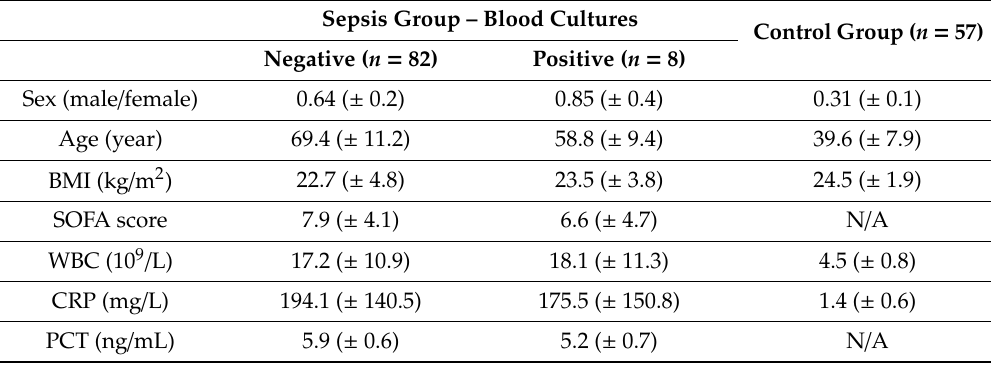
Table 1. Clinical characteristics of studied patient